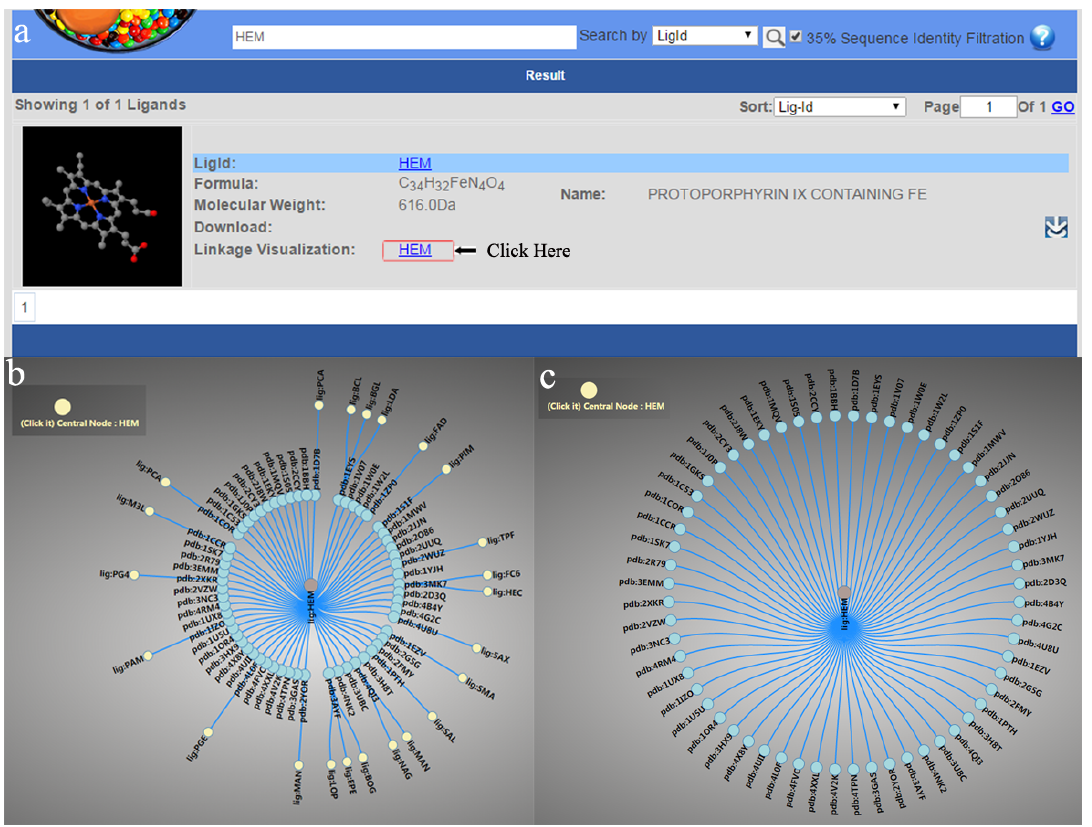
Figure 4. The Linkage visualization in MTLD. ( a ) The link for the linkage visualization; ( b ) two linkage layer mode visualization; ( c ) one linkage layer mode visualization.